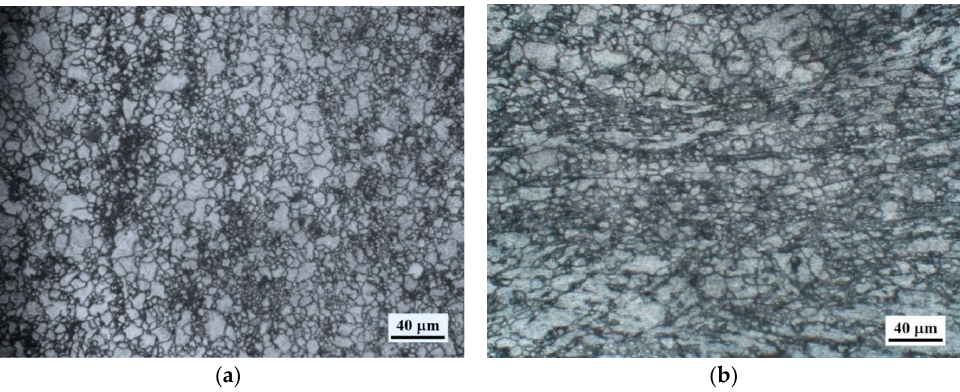
Figure 14. Deformed microstructures obtained for AZ31-2Ca alloy at 400 ° C/10 s − 1 ( a ) in DMD processed (Domain #2), showing DRX; and ( b ) in AC alloy, exhibiting static recrystallization occuring in localized bands.